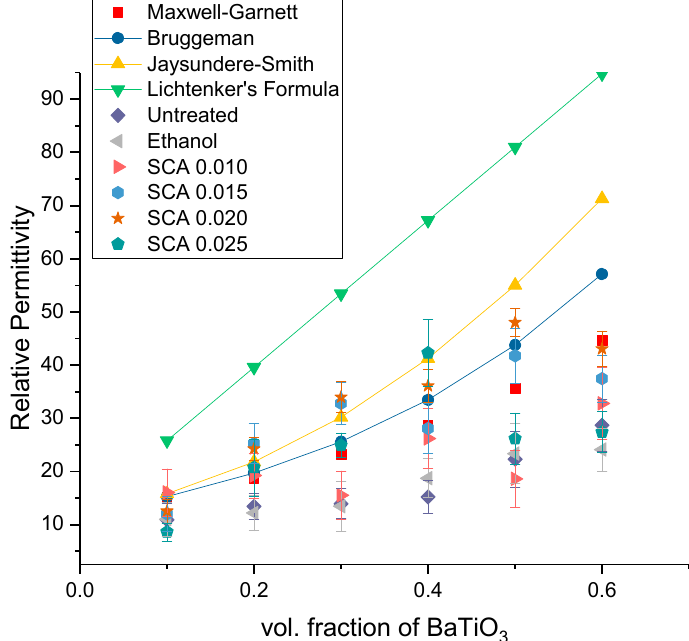
Figure 18. Comparison of the relative permittivity of the theoretical models with different experimental results, where the readings were taken at 20 MHz for the composites that were prepared using 0.5 volume fraction of BaTiO 3 .